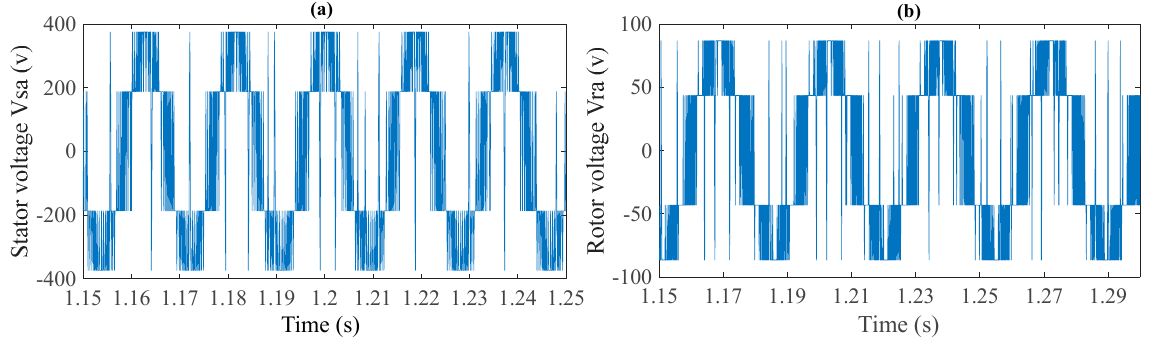
Figure 15. Stator Vsa ( a ) and rotor Vra ( b ) voltages of the GA–DTC .